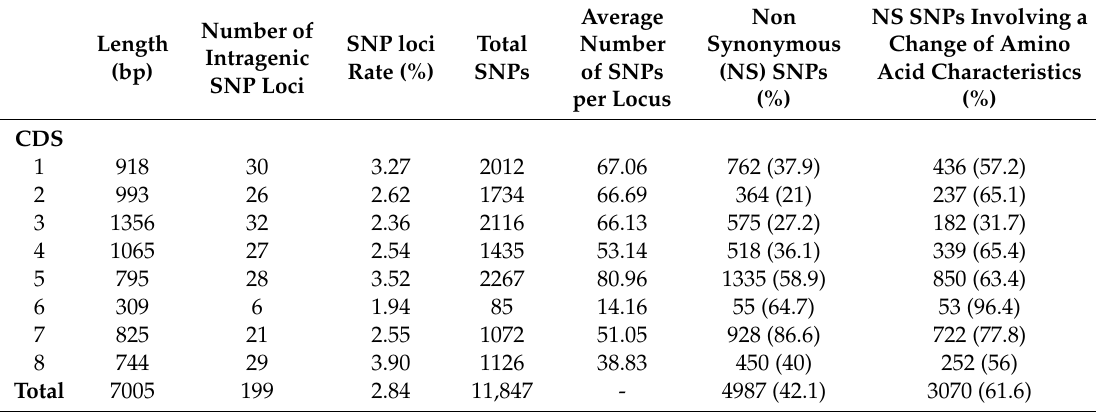
Table 2. Number of SNP loci, rates, and characteristics of all SNPs in dataset. CDS, coding sequence. SNP rate is the number of intragenic SNP loci (base positions containing at least one SNP in any of the 524 sequences in the dataset), compared to the length of the CDS, expressed as a percentage. Total SNPs is the total number of SNPs across the dataset for all variable sites. Average number of SNPs per locus is the average number of SNPs per variable site across the CDS in question. Nonsynonymous SNPs per CDS are presented, along with the % of total SNPs. Nonsynonymous (N-S) SNPs involving a change of amino acid characteristics also shown as a percentage of the total number of nonsynonymous SNPs.